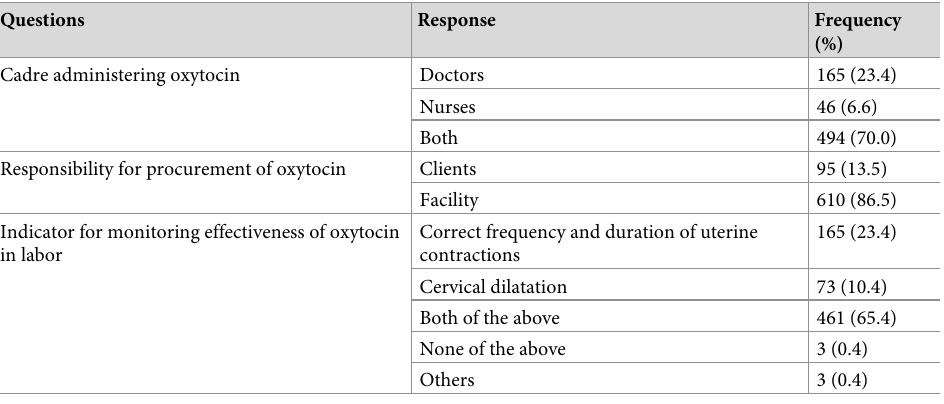
Table 5. Respondents’ general practice with oxytocin ( n =